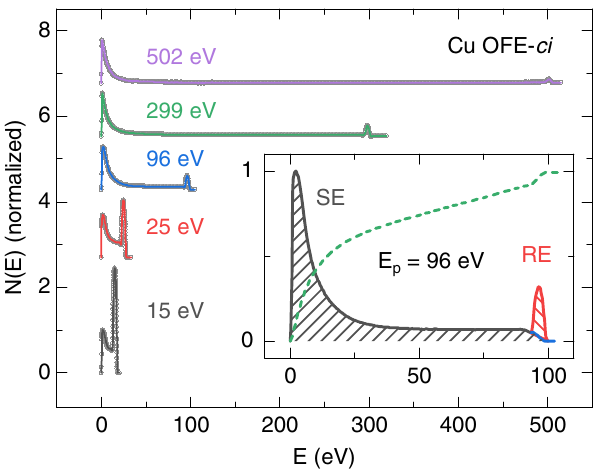
FIG. 1. Energy distribution curves, N ð E Þ , of secondary and elastically reflected electrons as a function of their kinetic energy, E , and for the indicated primary energy, E , of incident electrons p for Cu OFE samples that had been cleaned by ion bombardment ( ci ). Raw (smoothed) data appear as dots (solid lines). The spectra are normalized by setting the SE peak height to unity. N ð E Þ ≥ 25 eV are vertically offset. Inset: definition of data with E p secondary-electron (SE) and reflected-electron (RE) contribu- Þ and ϱ ð E Þ for (a) ar and (b) ce samples. tions to the total number of emitted electrons. SE and RE areas FIG. 2. Fractions σ ð E p p are separated by the Shirley background (blue line). Numerically The same symbols as in (a) are used for ce samples in (b); R N ð E Þ d E , are normalized to unity and presented integrated data, reversed triangles are chosen for Cu OFE- ci . Solid lines represent Þ data using Eq. by the dashed green line. fits to the ϱ ð E p